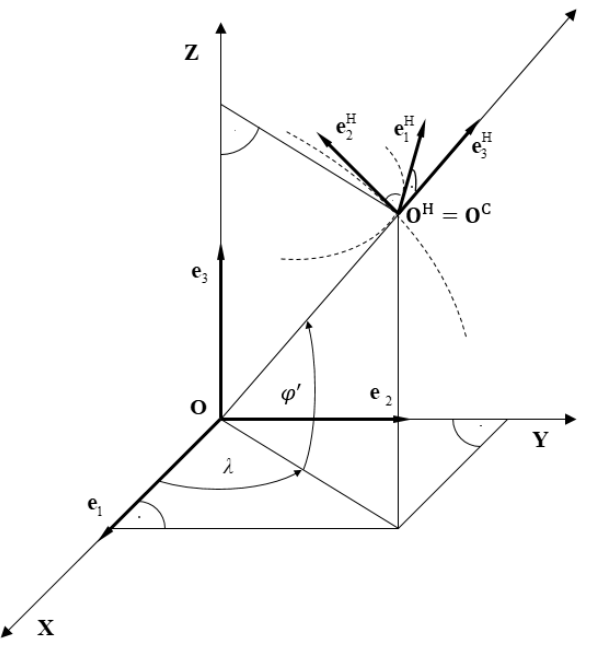
Figure 3. Arrangement of reference systems in relation to each other, T H and T space E 3